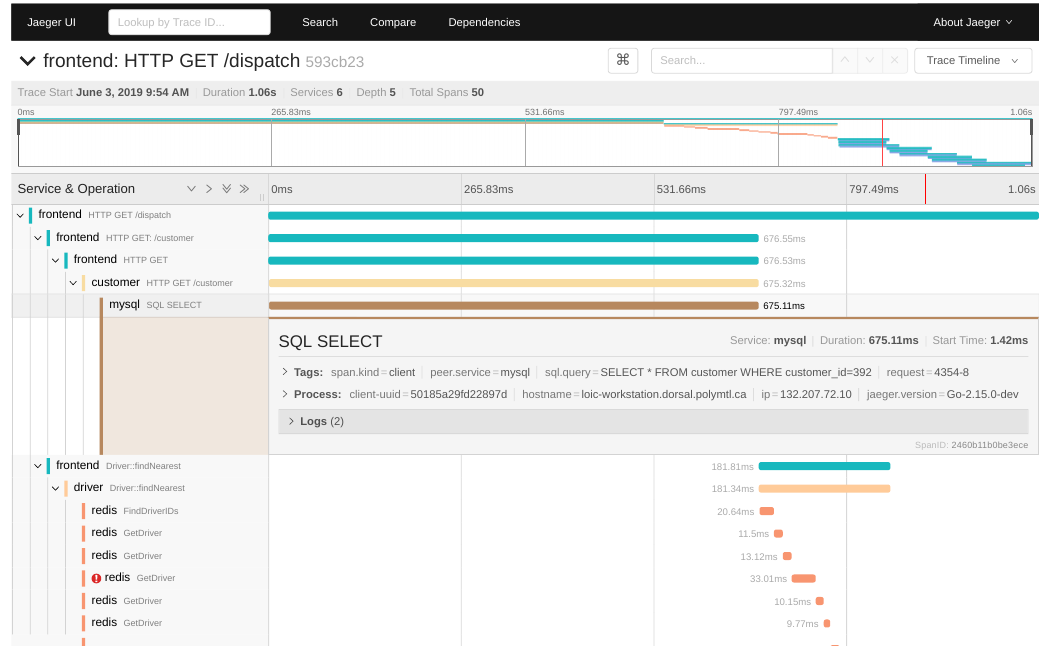
Figure 1. Sample distributed trace shown by Jaeger . The events corresponding to a user request can be collected and processed by the distributed tracer Jaeger . The view shows the complete flow of subrequests, along with the causal links between them, their duration and their log events.